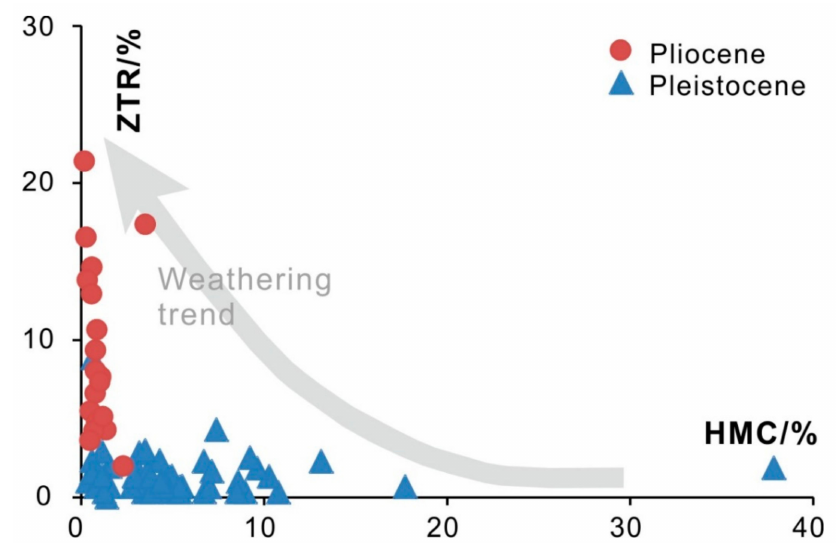
Figure 1. Stable minerals (ZTR) vs. heavy mineral concentration of Pliocene and Pleistocene sediments from the Core LQ24 of the Changjiang Delta. HMC = Heavy mineral concentration; the ZTR index [11] is the percentage of relatively durable zircon, tourmaline, and rutile among the transparent heavy minerals. The high HMC values in some of the Pleistocene samples define a placer trend [13], and diagenetic dissolution in the Pliocene sand produces a decrease in HMC and an increase in ZTR. In this study, unstable (amphibole, epidote) and stable (tourmaline) heavy mineral in grain size fractions of 32–63 µ m and 63–125 µ m were analyzed by using a scanning electron microscope